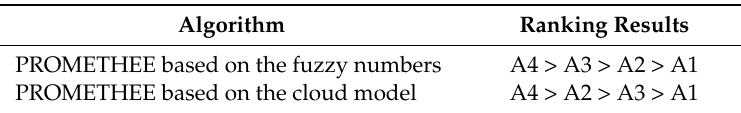
Table 15. Comparison between different